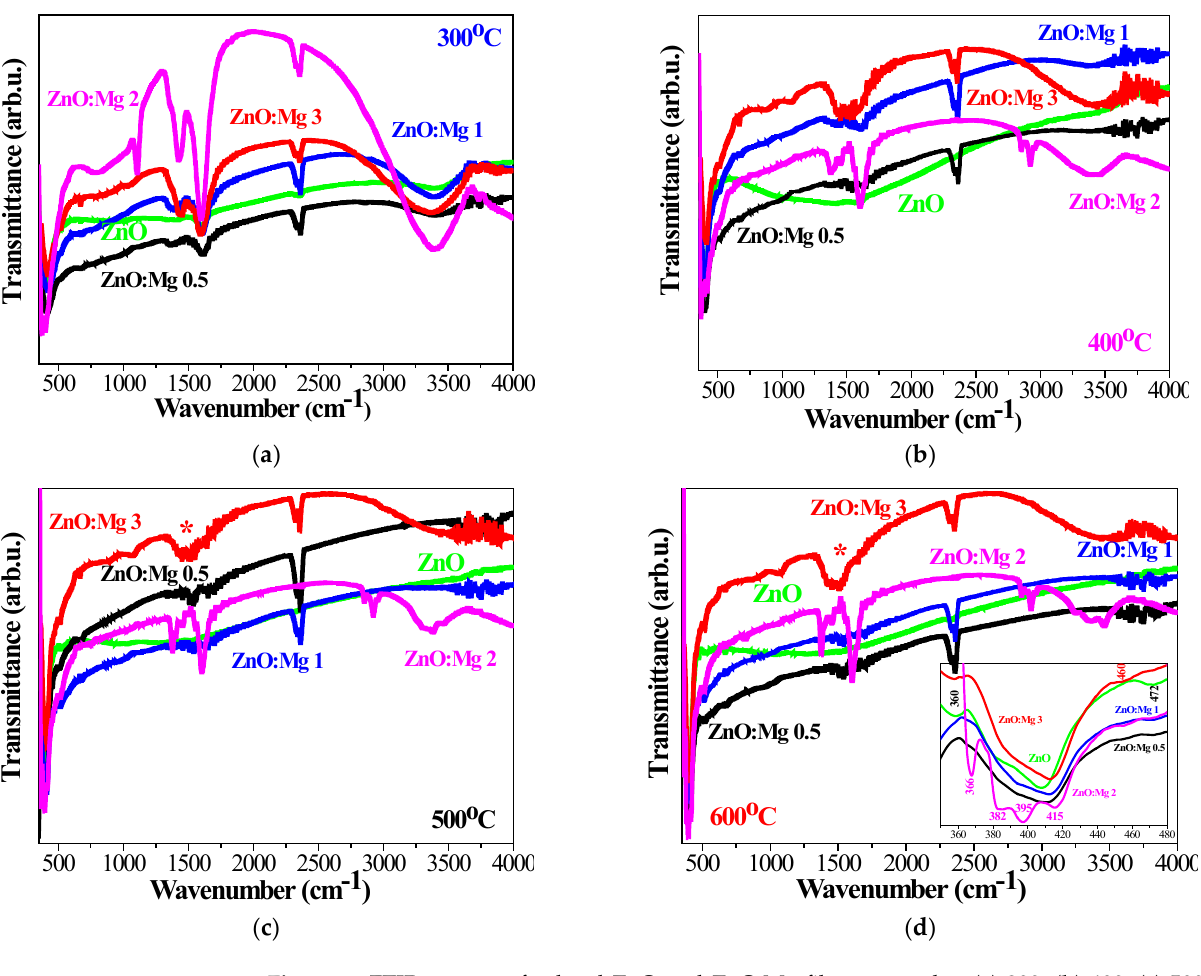
Figure 9. FTIR spectra of sol–gel ZnO and ZnO:Mg films, treated at ( a ) 300, ( b ) 400, ( c ) 500 and ( d ) 600 °C. The inset figure in ( d ) presents FTIR spectra of 600 °C annealed samples in the extended spectral range 350–480 cm -1 . The asterisk * in ( c , d ) denotes the absorption band due to Mg–O vibrations.